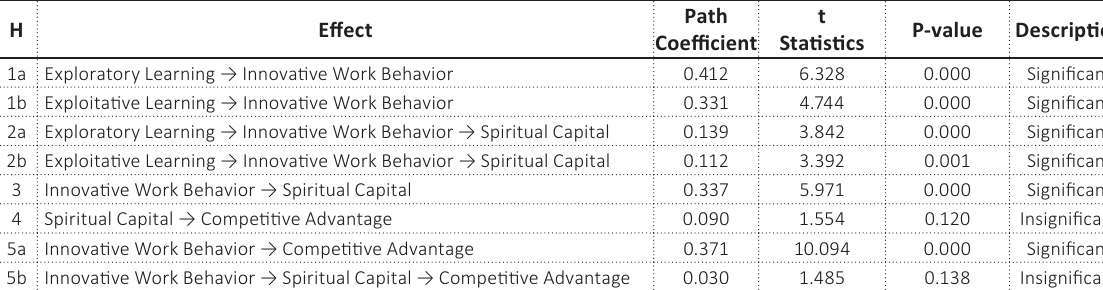
Table 3. Hypotheses testing